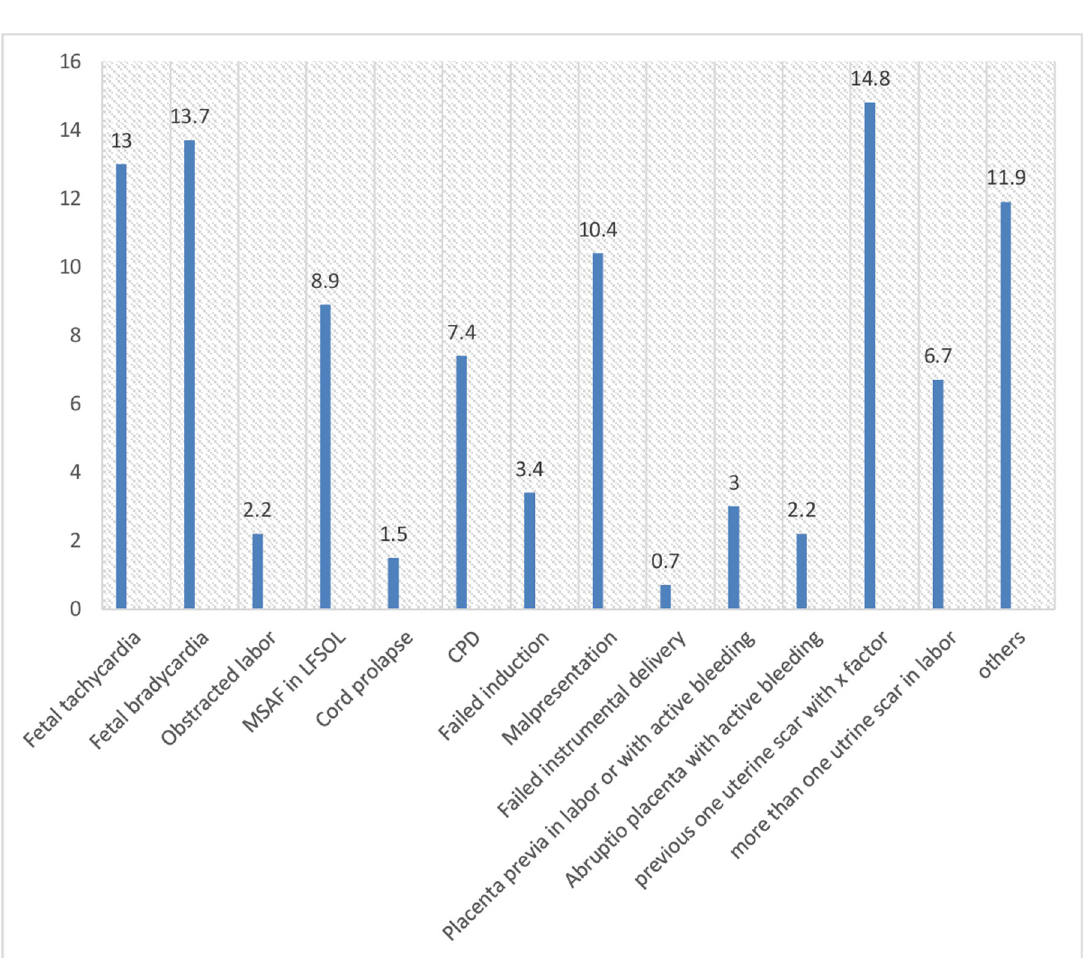
Fig 2. Indications for cesarean delivery in women with emergency C/S in HUCSH,